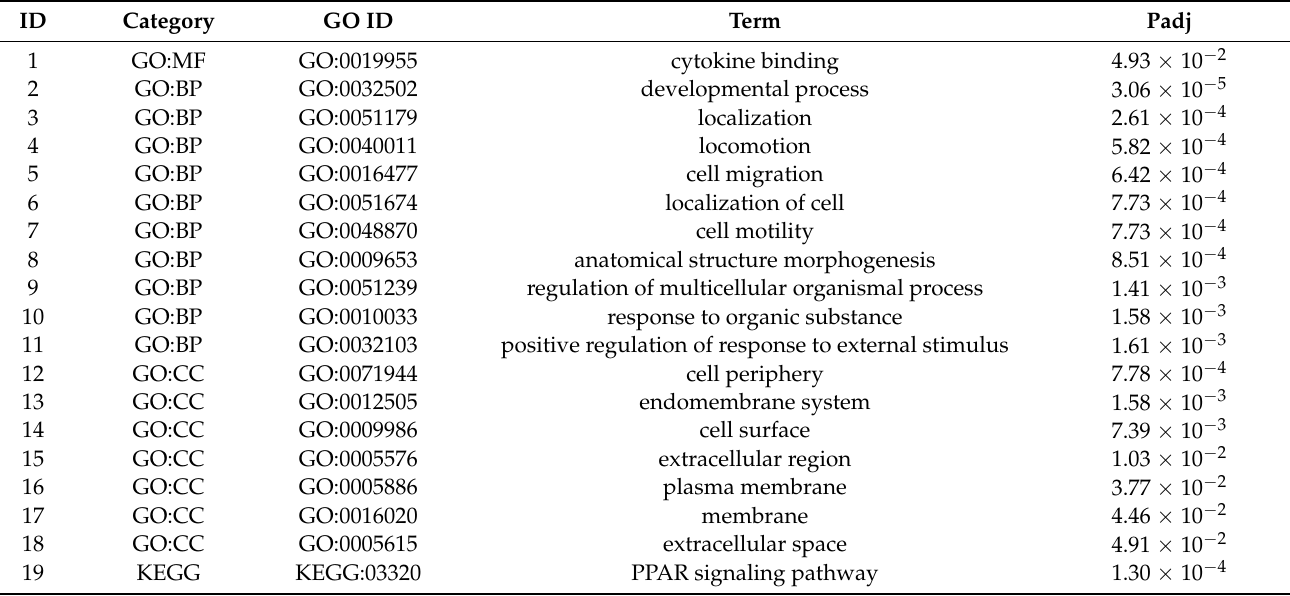
Table 4. Top 10 of each gene ontology (GO) molecular function (MF), biological processes (BP), and cellular component (CC) and KEGG terms.